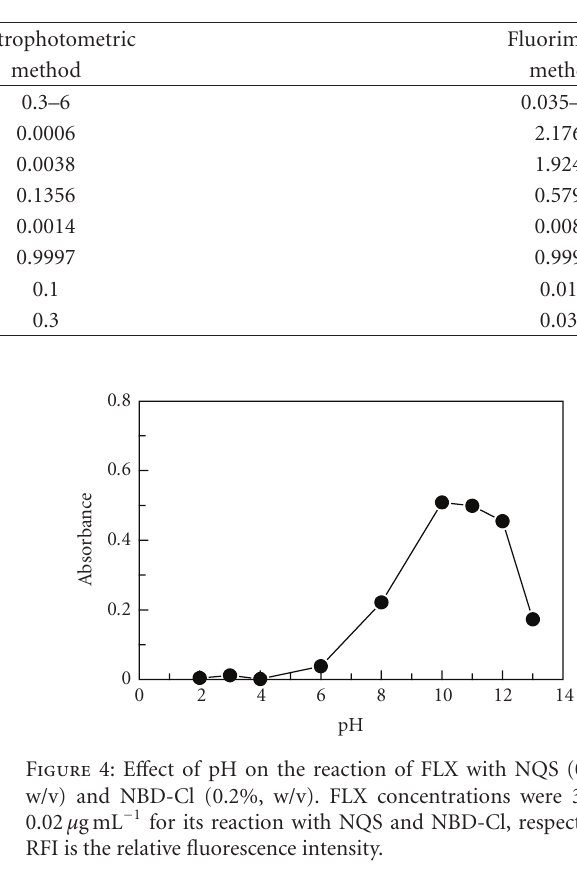
Table 2: Analytical parameters for the proposed spectrophotometric and fluorimetric methods for determination of FLX based on its reaction with NQS and NBD-Cl, respectively.